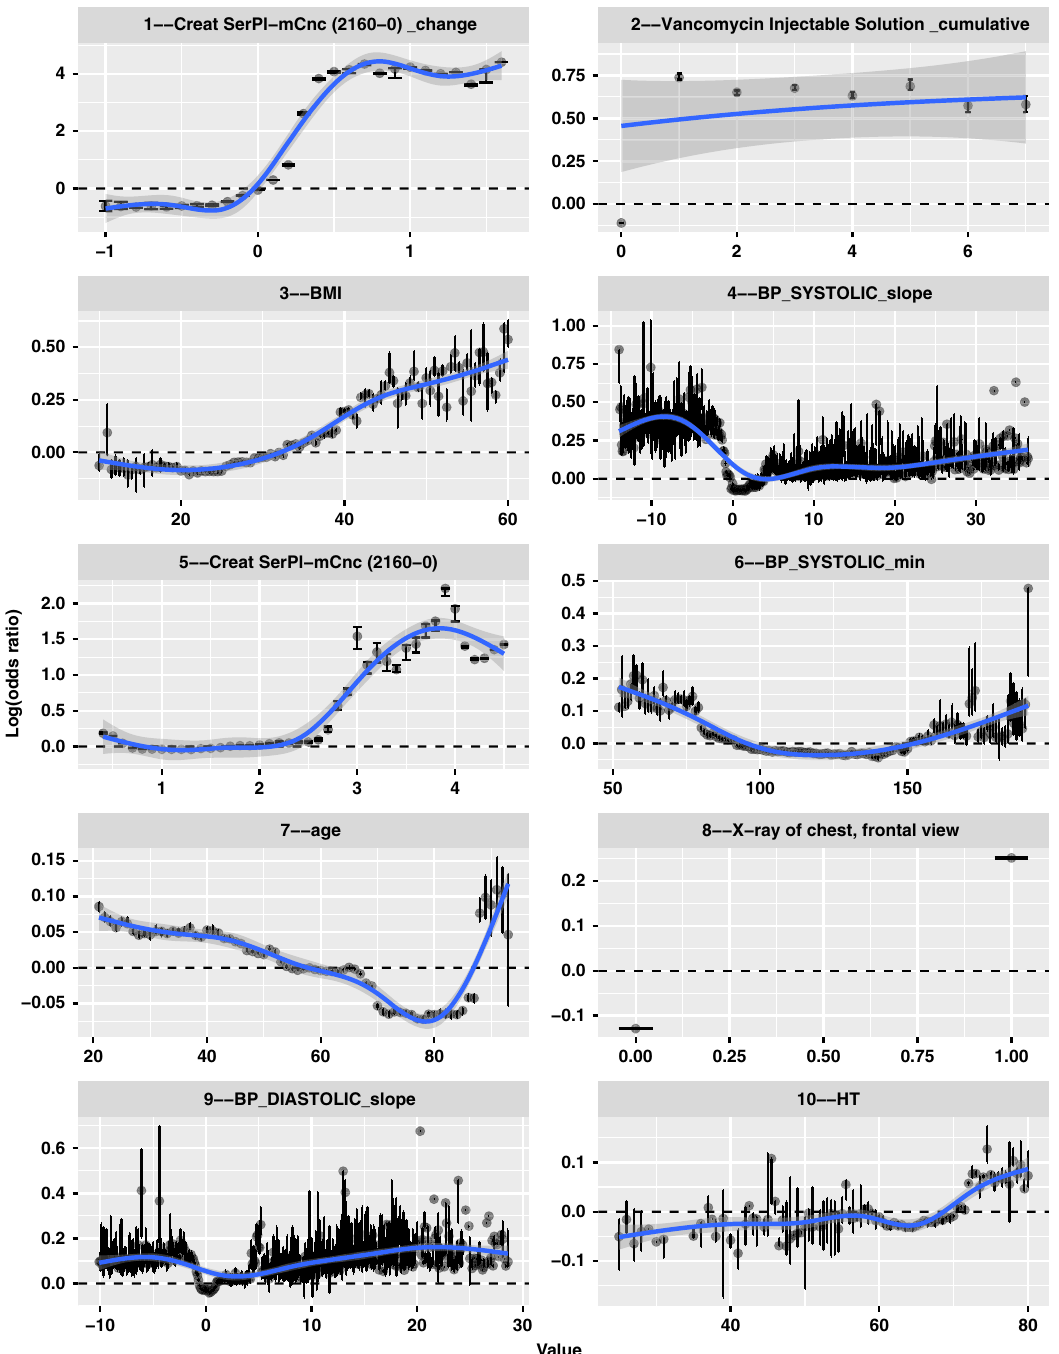
Fig. 2 Marginal plots of the top 10 important variables for predicting moderate to severe AKI (at least AKI stage 2) in 48 h. Each panel demonstrates marginal effects of each of the most impactful features ranked among the top 10 for predicting moderate-to-severe AKI in 48 h with SCr and BUN in the model. The x -axis gives the raw values of each feature and the y -axis gives the logarithmic of estimate odds ratio (i.e., the SHAP value) for moderate-to- severe AKI in 48 h when a feature takes certain value. Each dot represents the average SHAP value over bootstrapped samples with the error bars suggesting a 95% bootstrapped interval. The ‘ shaded area ’ represents the 95% con fi dence band for the LOWESS smoother extrapolating across all the dots. The full interactive dashboard can be found at: increase of odds by exp (0.1) = 1.2 fold; while a systolic blood AKI ≥ 2. Chest X-ray procedure was associated with an increased pressure drop by more than 5 mmHg/hour were shown to be odds of exp (0.3) = 1.3 fold, while piperacillin-tazobactam injection associated with increasing odds by at least exp (0.4) = 1.5 fold. At the increased odds by exp (0.5) = 1.6 fold. Age younger than 40 or older patient-encounter level, we designed another dashboard (https:// than 85 were identi fi ed to increase odds by exp (0.05) = 1.1 fold (detailed explanation is available in discussion); a minimal systolic lized predictors of moderate-to-severe AKI risk by decomposing the blood pressure <75 mmHg or >150 mmHg both suggested an